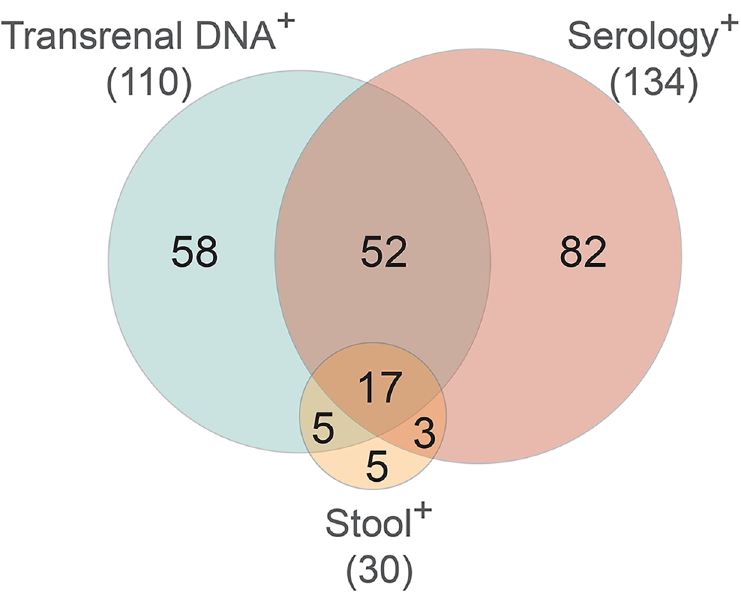
Fig 1. Venn diagram comparing the patient distribution of the 222 positive results of the transrenal DNA PCR, NEI ELISA serology and stool examination assays measuring Strongyloidesstercoralis infection status.